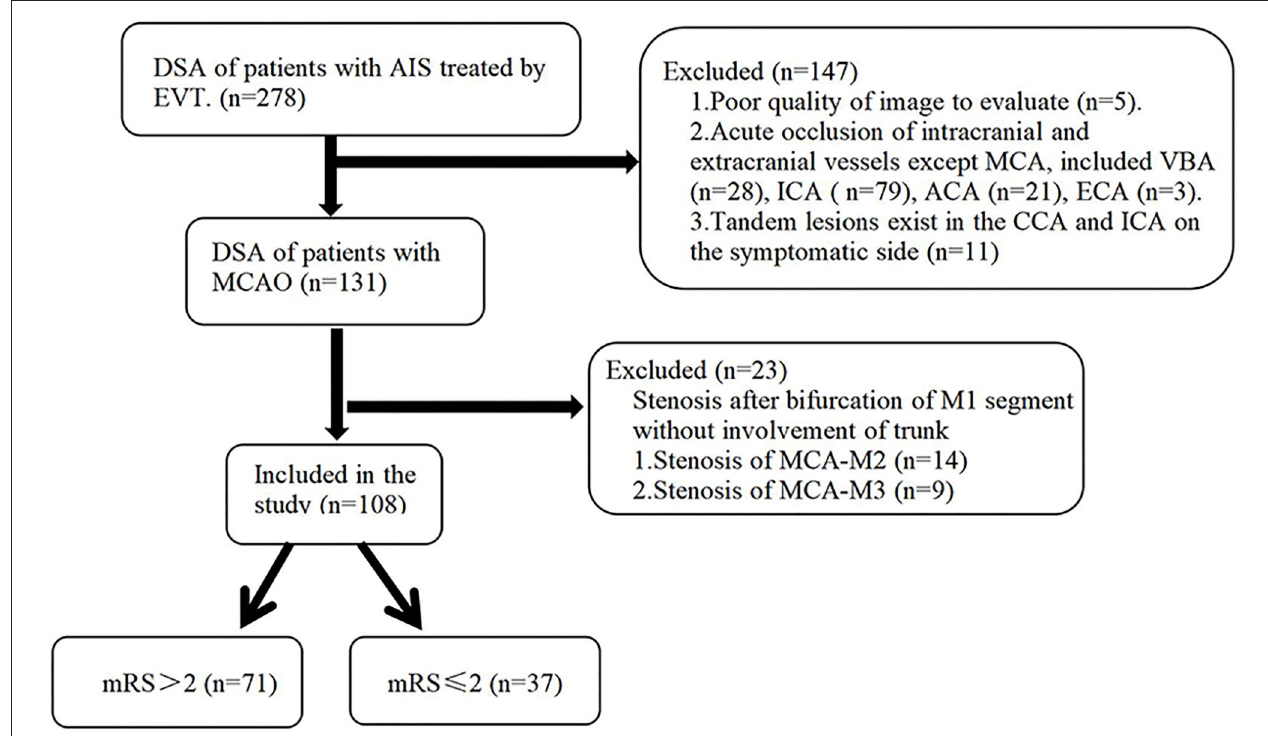
FIGURE 1 | Block diagram of enrollment into this study. MCAO, middle cerebral artery occlusion; ABZA, anterior borderzone angle grading; mRS, modified Rankin score; PCA, posterior cerebral artery; ACA, anterior cerebral artery; CCA, common carotid artery; ECA, external carotid